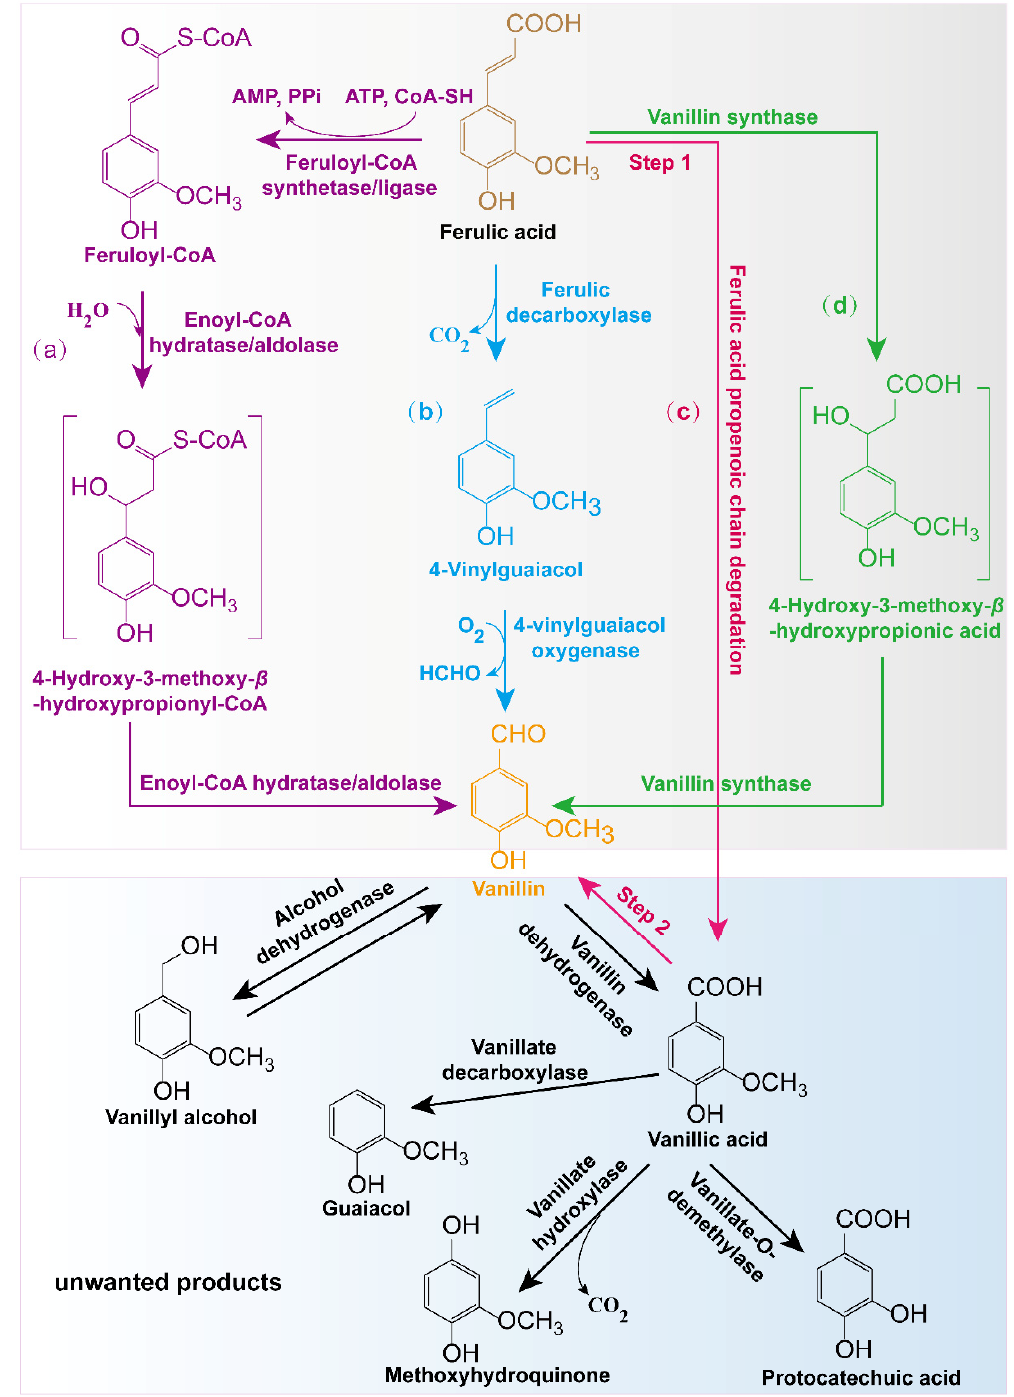
Figure 2. Pathways for the production of ferulic acid-derived vanillin using biotransformation methods and related producers: ( a ) CoA-dependent conversion in most microorganisms or engineered bacteria such as Amycolatopsis , Pseudomonas , Sphingomonas paucimobilis SYK-6, Streptomyces , Pediococcus acidilactici BD16, and E. coli [3,9]; ( b ) CoA-independent conversion designed in recombinant E. coli [10]; ( c ) a two-step conversion pathway for vanillin production combining Aspergillus niger and Pycnoporus cinnabarinus [11]; ( d ) a one-step synthetic pathway for the production of vanillin in plant cells [12].